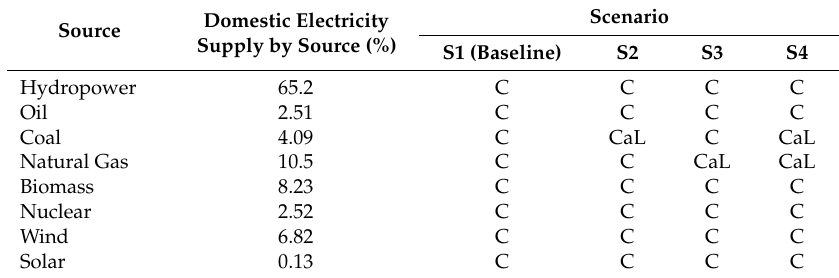
Table 1. Specification of the analysis scenarios by type of electricity generation source Scenario Source Domestic Electricity Supply by Source (%) S1 (Baseline) Hydropower 65.2